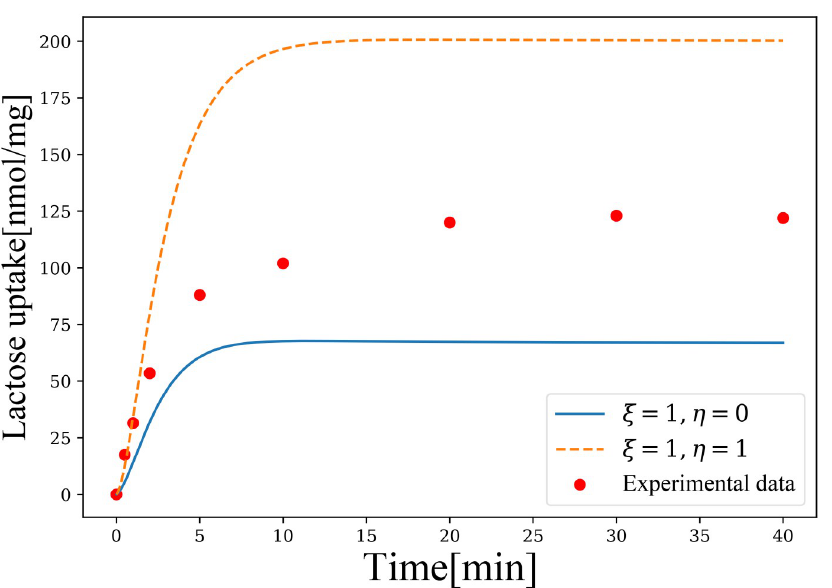
Fig 9. Lactose translocated into cytoplasm by E . coli T184 wild-type lactose permease. The horizontal axis of the graph indicates the time E . coli T184 cells were incubated under specific conditions, and the vertical axis shows the increase in lactose concentration in cytoplasm compared to the initial condition. The red dots are the experimental data extracted from the article of Ujwal et al [19]. The solid and dashed lines are the results of our simulations when ξ = 1, η = 0 and ξ = 1, η = 1,